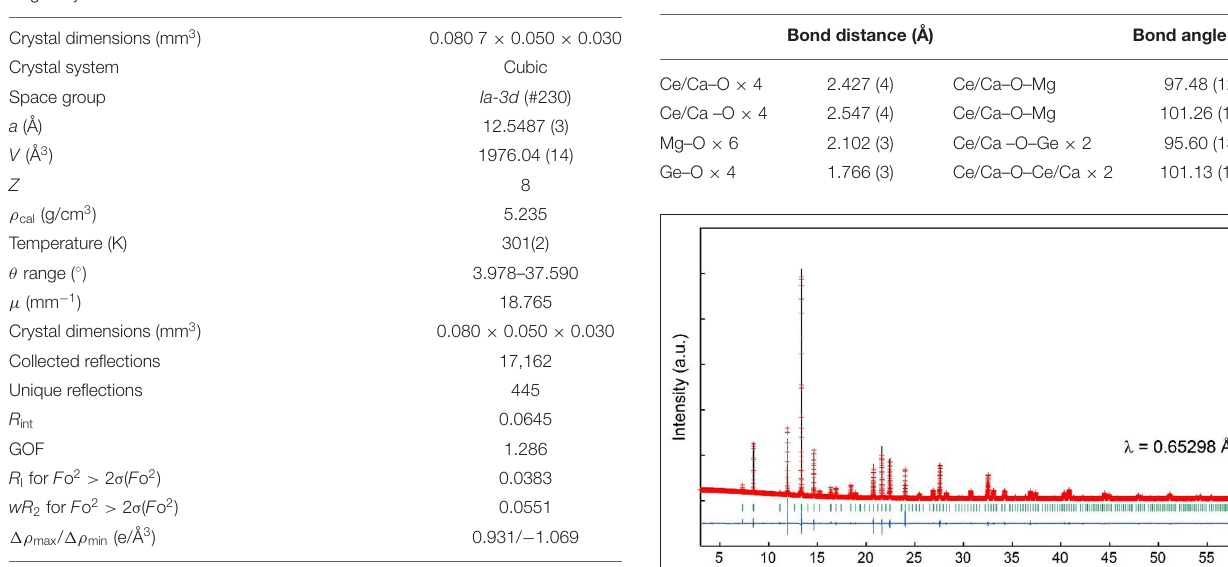
TABLE 3 | Selected interatomic distances and bond angles of Ce 2 CaMg 2 Ge 3 O 12 at 301K.